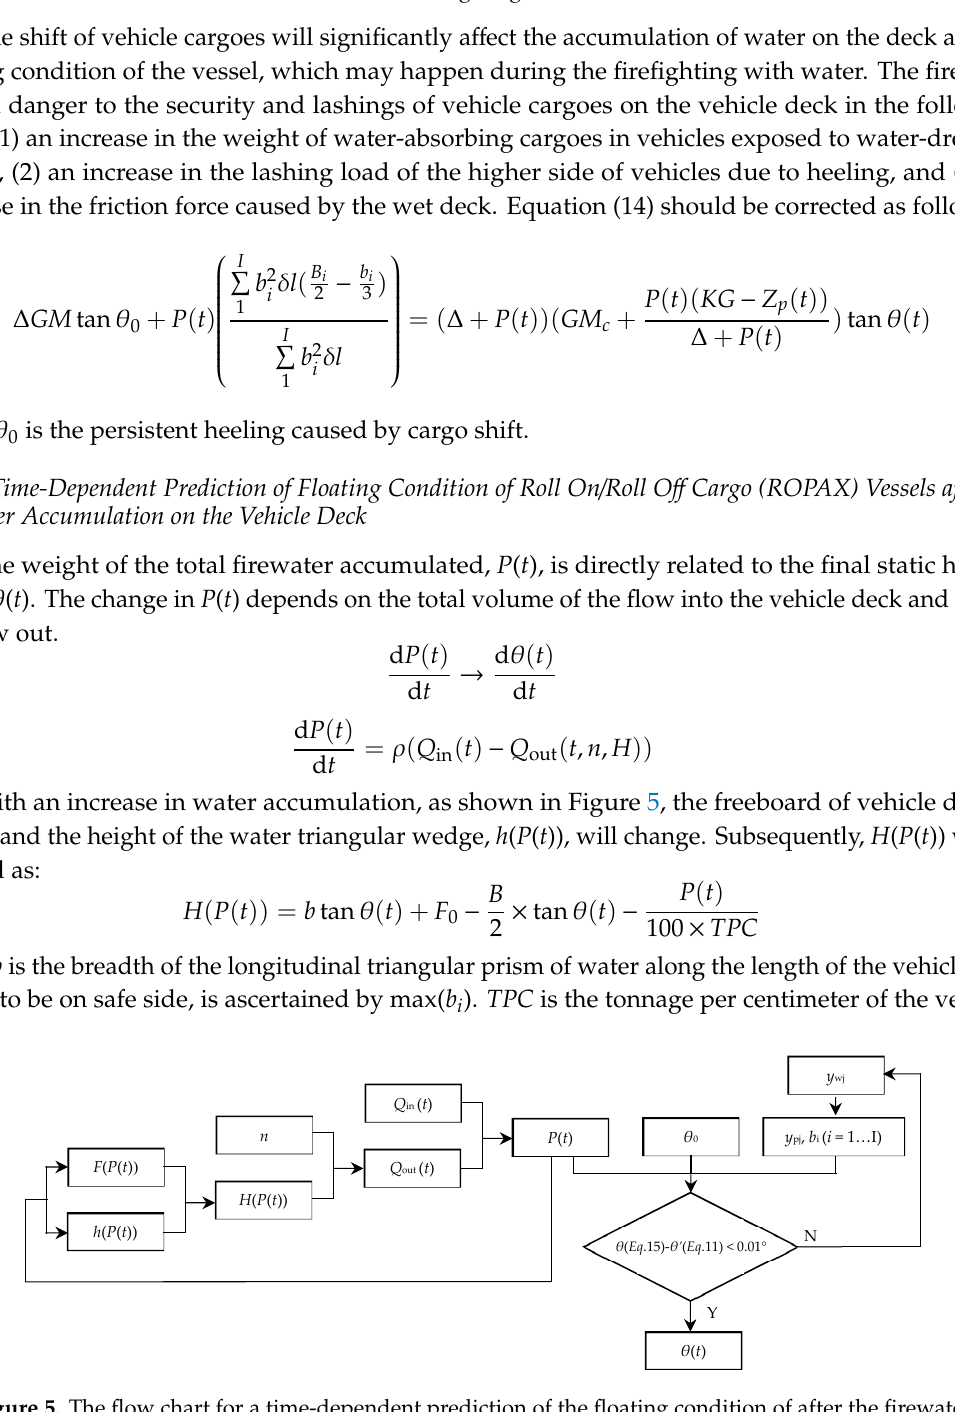
Figure 5. The flow chart for a time-dependent prediction of the floating condition of after the firewater accumulation on vehicle deck D.